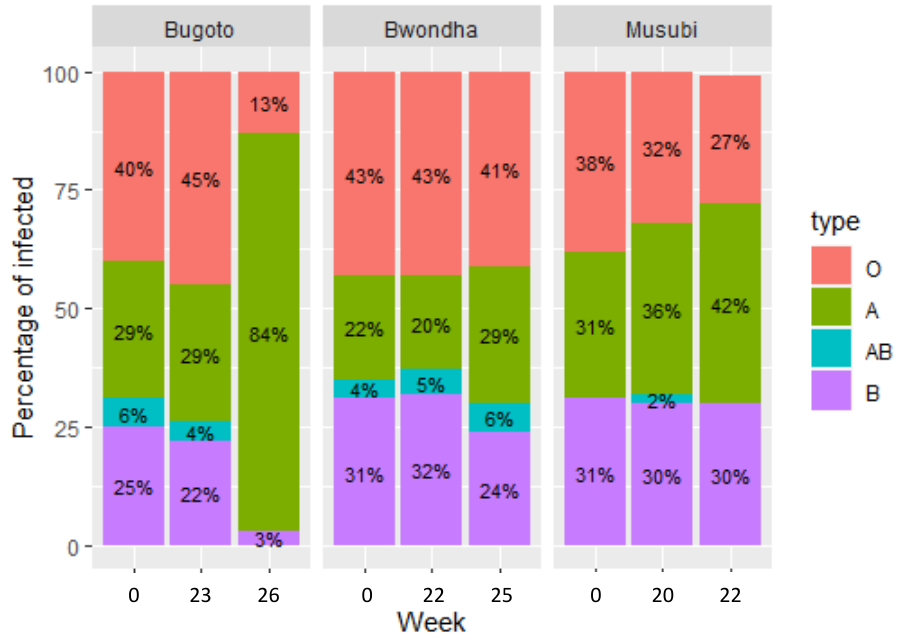
Figure 2. Schistosoma mansoni infection prevalence, split by school, host blood type, pretreatment, six months post-treatment, and then three weeks later after re-treatment. Blood groups are denoted by colour.